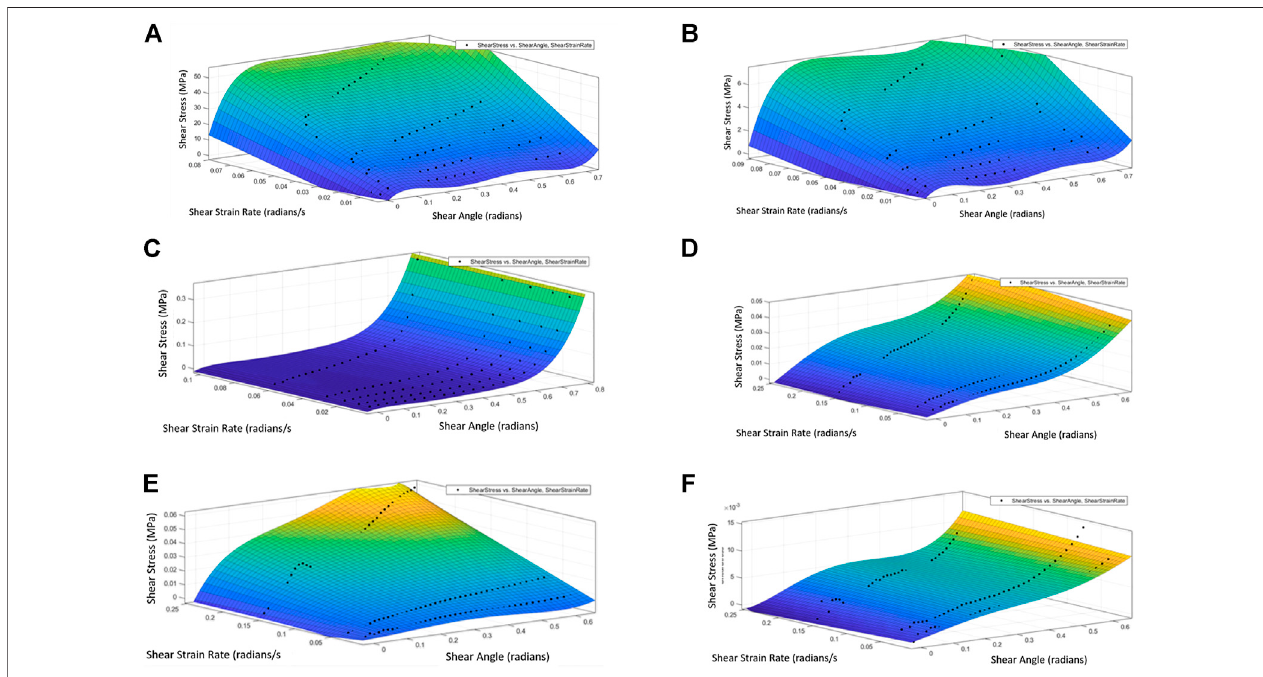
FIGURE 7 | Surface fi t of the shear stress response at various strain rates (A) simulated 50% coverage (B) simulated 5% coverage (C) simulated dry fabric (D) experimental visco-elastic 50% coverage (E) experimental visco-elastic 100% coverage (F) experimental dry fabric.